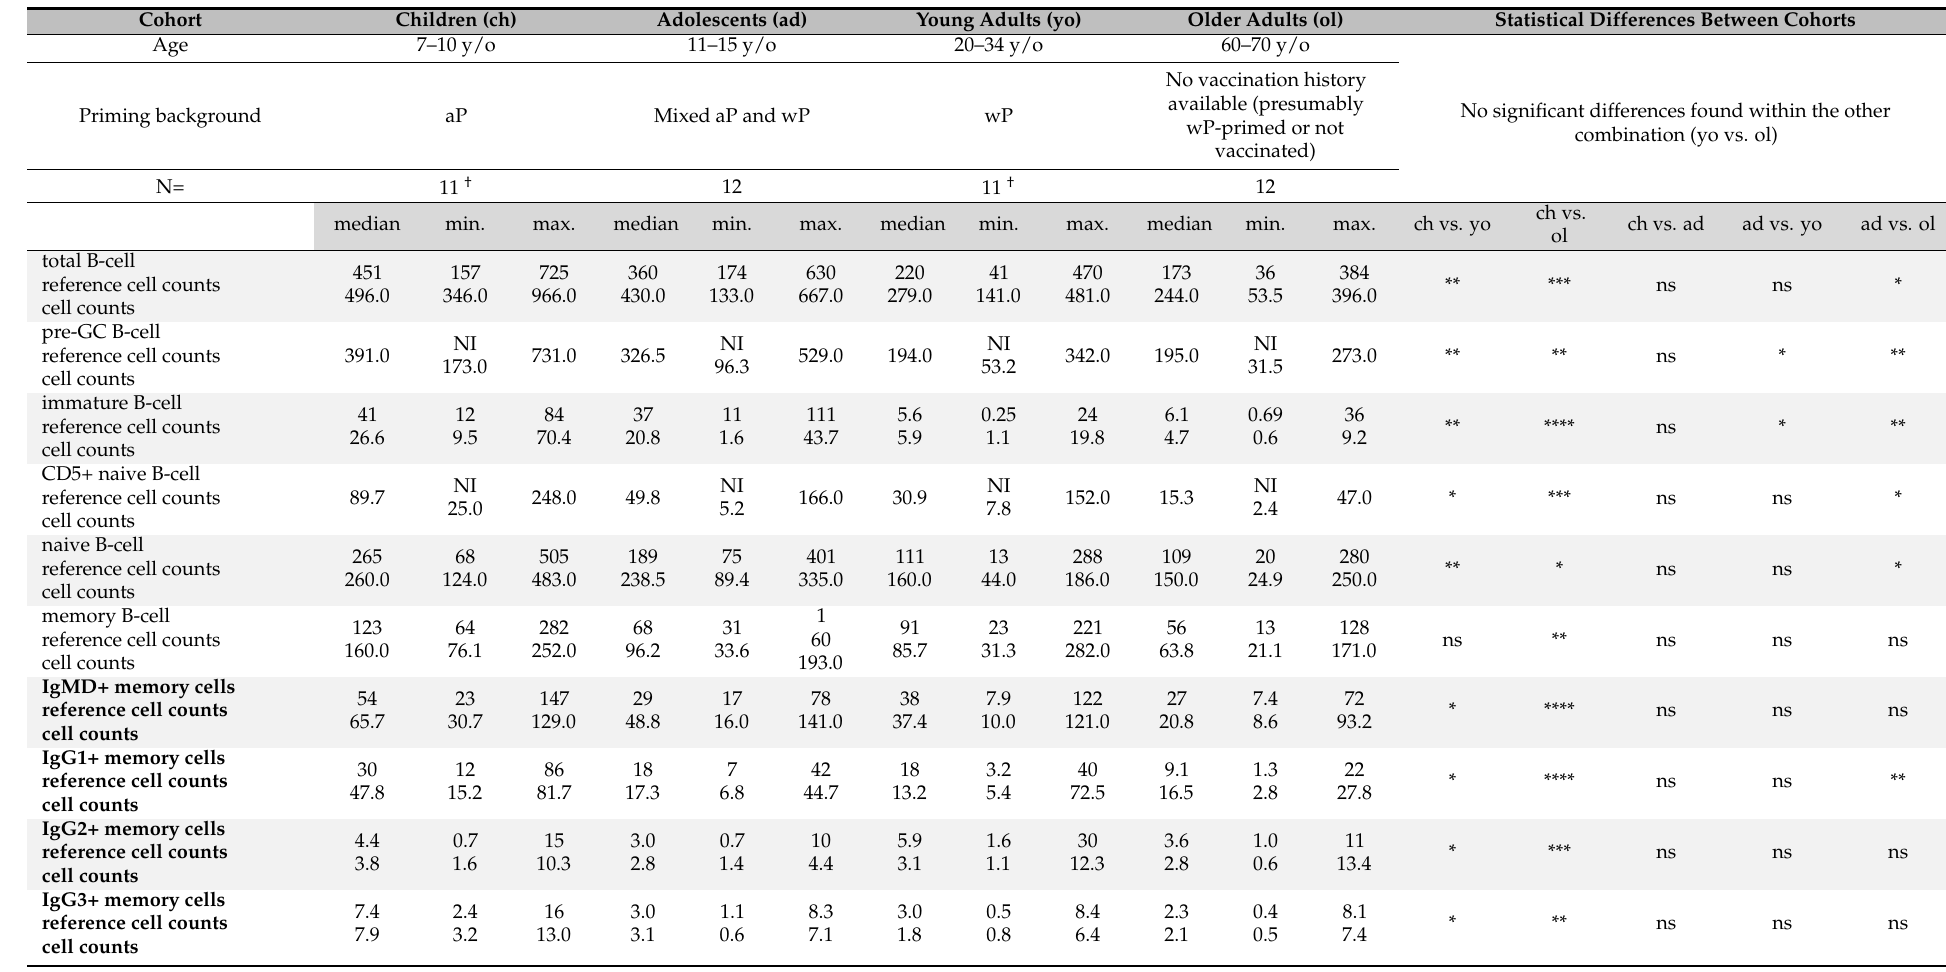
Table 1. Baseline distribution of normal B-cell and plasma cell subsets (cells/ µ L) in each age cohort. Ages of the cohorts of which reference values were